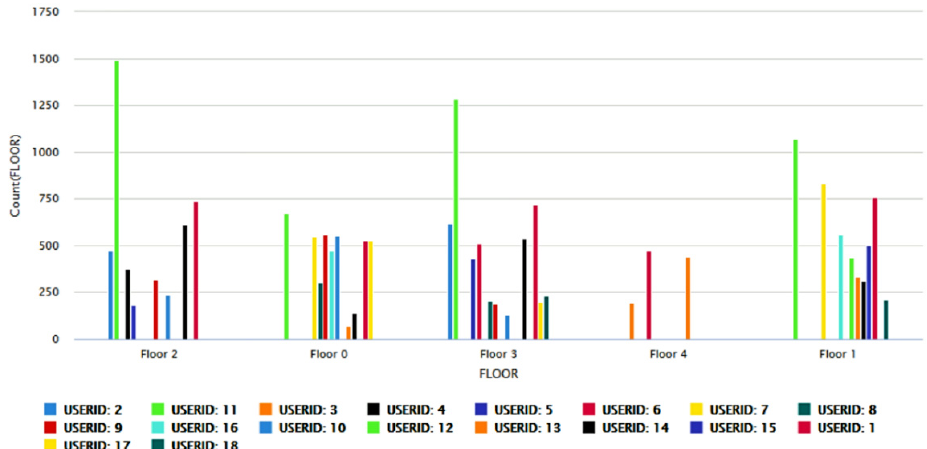
Figure 5. A bar plot representing the number of times the different users were present on specific floors in different buildings, where the plot is grouped by the value of the attribute—Floor.